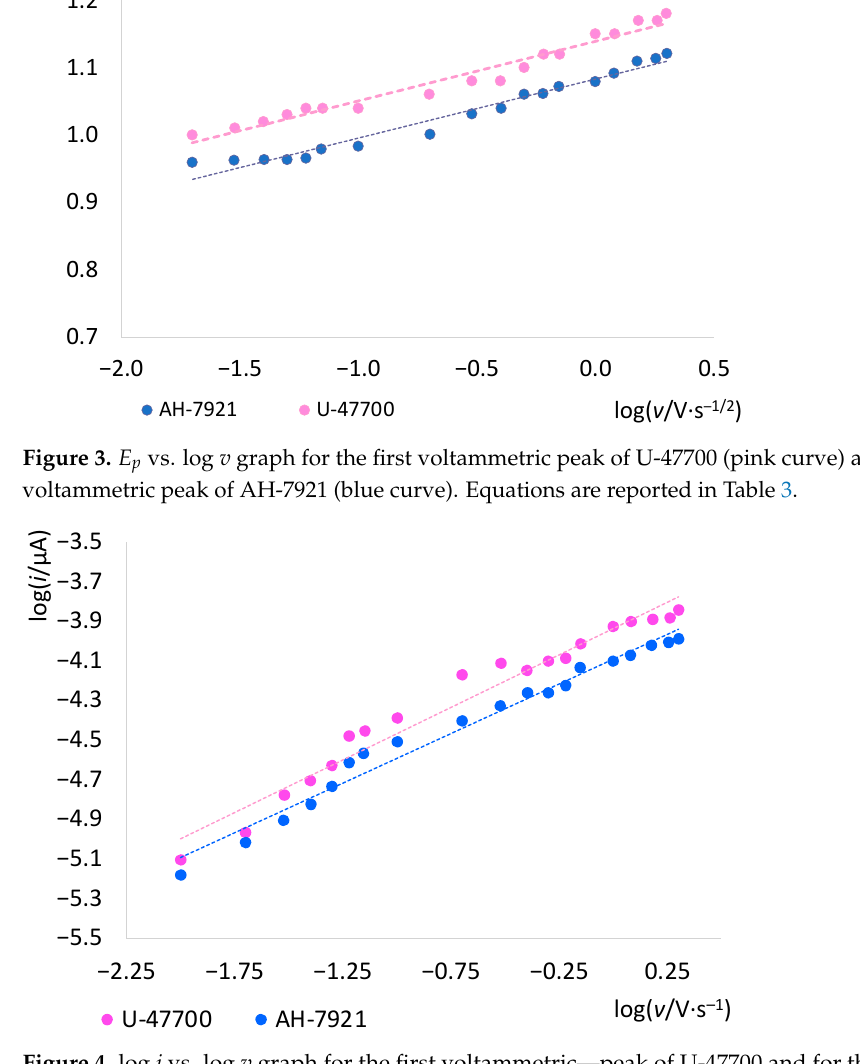
Figure 4. log i vs. log v graph for the first voltammetric—peak of U-47700 and for the first voltammetric peak of AH-7921. Equations are reported in Table 3.